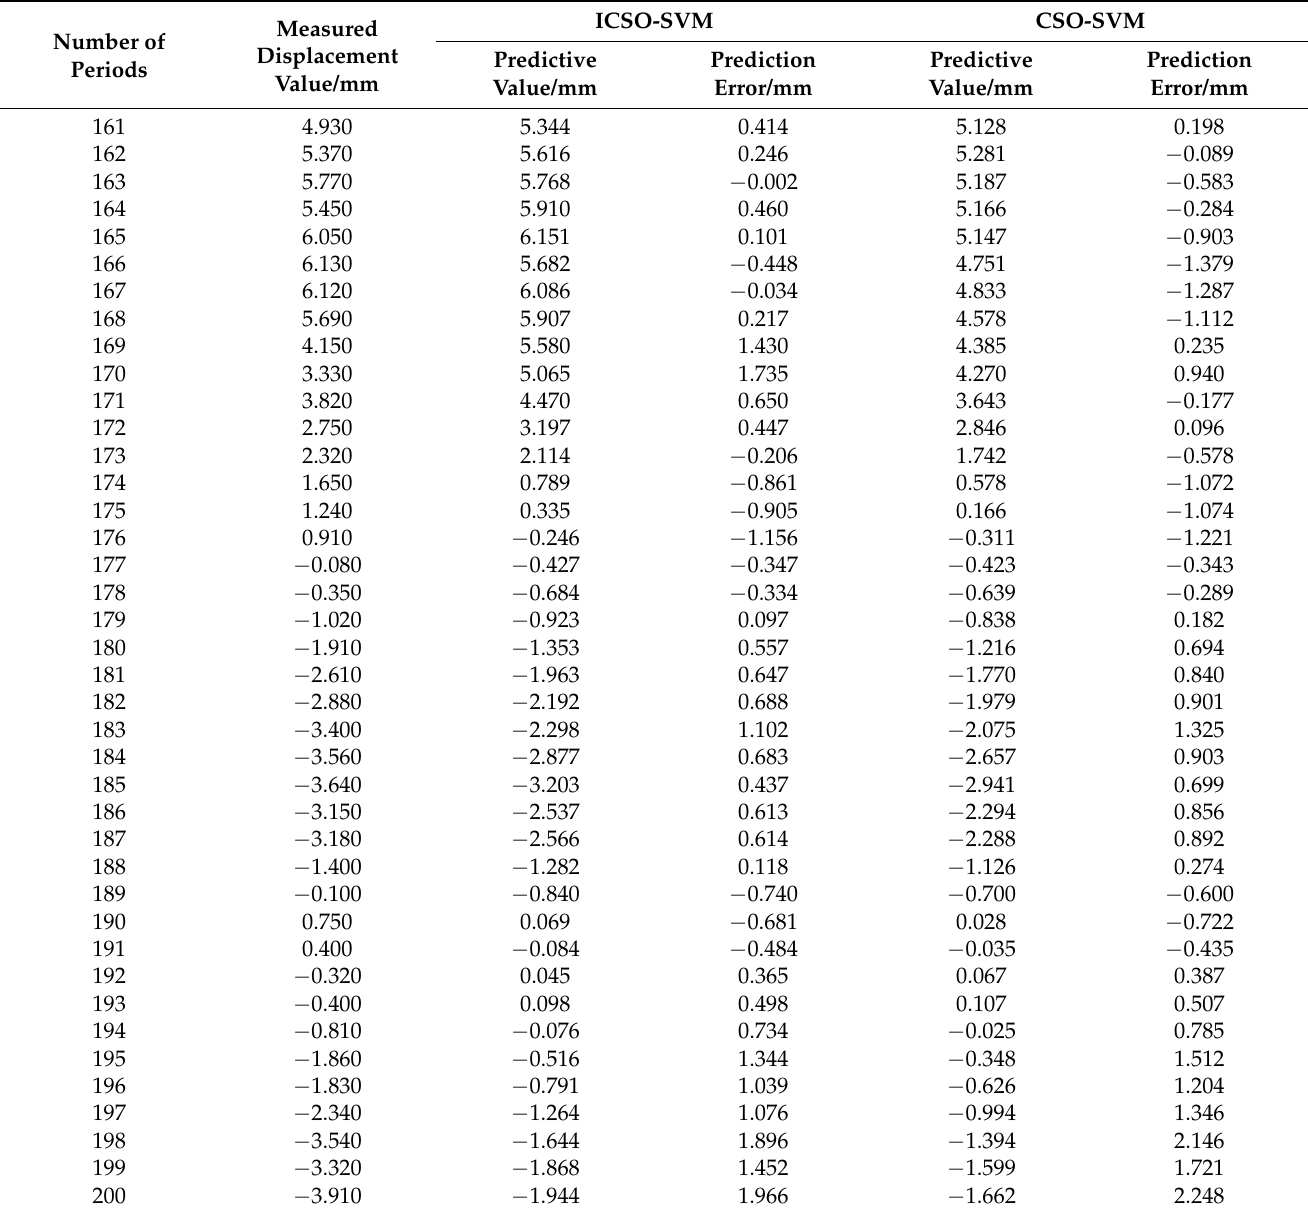
Table 3. Comparison of horizontal displacement prediction results between ICSO-SVM and CSO- SVM